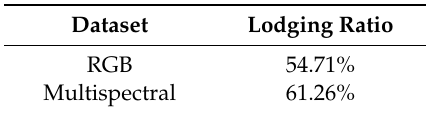
Figure 10. Field marker: ( a ) field marker of RGB image; ( b ) field marker of multispectral image. Table 4. Ratio of